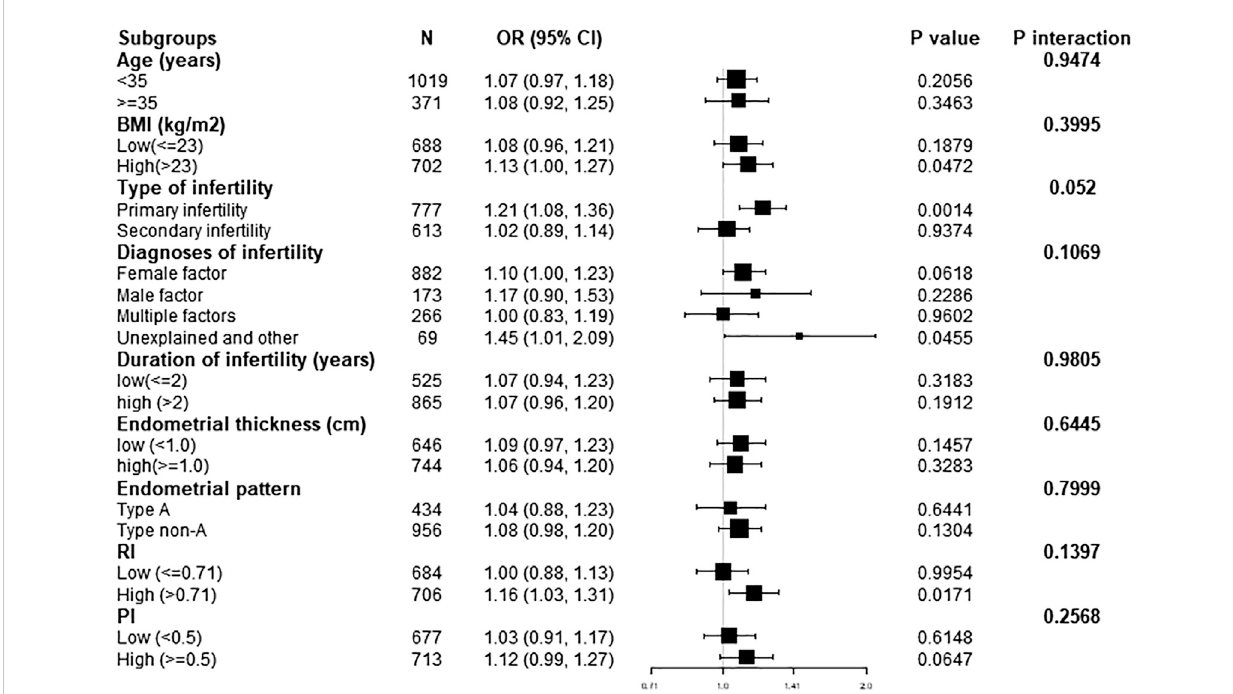
FIGURE 1 Effectsizeofendometrialblood fl owbranchesonclinicalpregnancyoutcomesineachsubgroup.Adjusted,ifnotstrati fi ed,forage;BMI;durationof infertility; diagnosis of infertility; type of infertility; endometrial thickness; endometrial patten; RI; PI. BMI, body mass index; Cl, con fi dence interval; FET, frozen embryo transfer; OR, odds